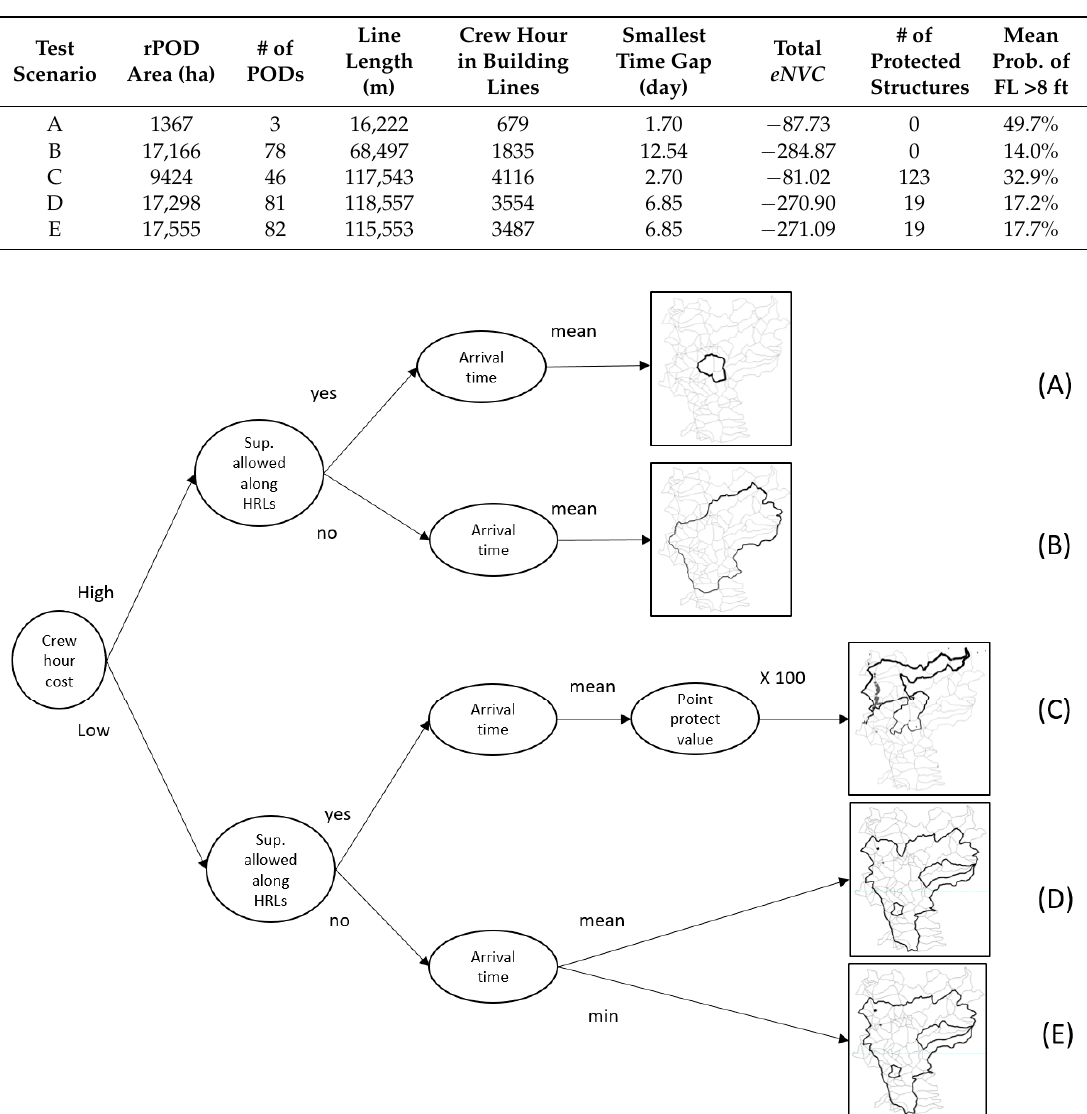
Figure 6. A conceptual decision tree illustrating incorporation of manager risk preferences into development of optimal solution. Scenarios ( A – E ) correspond to the solutions presented in Table 3. The displayed points in scenarios C, D and E are structures protected through point protection.